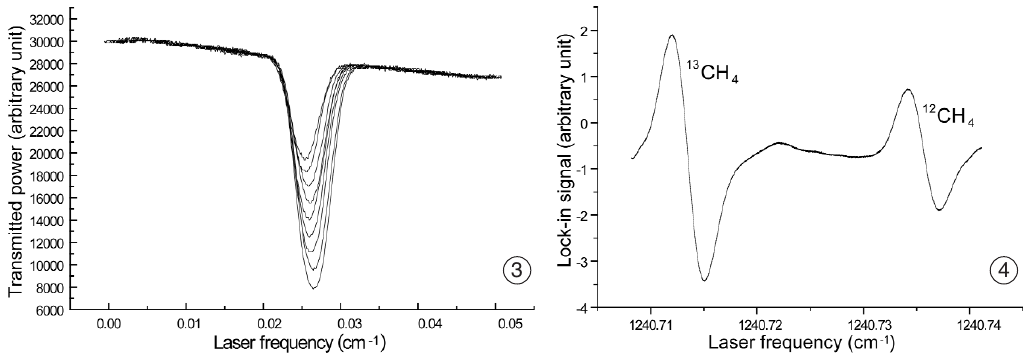
Fig. 3. Direct absorption spectrum of pure methane, around 1241 cm − 1 . The gas pressure in the cell was varied from 100 to 400 mTorr. Fig. 4. Simultaneous detection of 13 CH 4 and 12 CH 4 , in natural isotopic abundance (1.1% and 98.9%, respective- ly), in the presence of 150 mTorr of pure